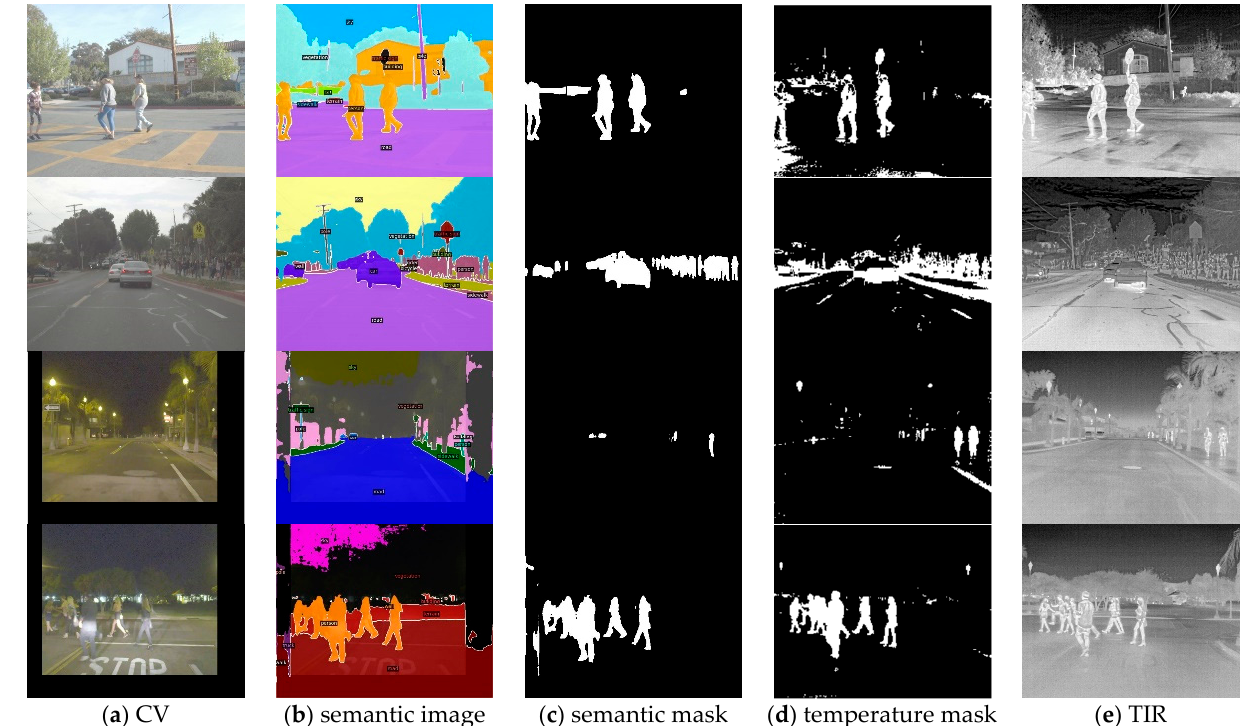
Figure 3. Temperature masks and semantic masks in different illumination scenarios.